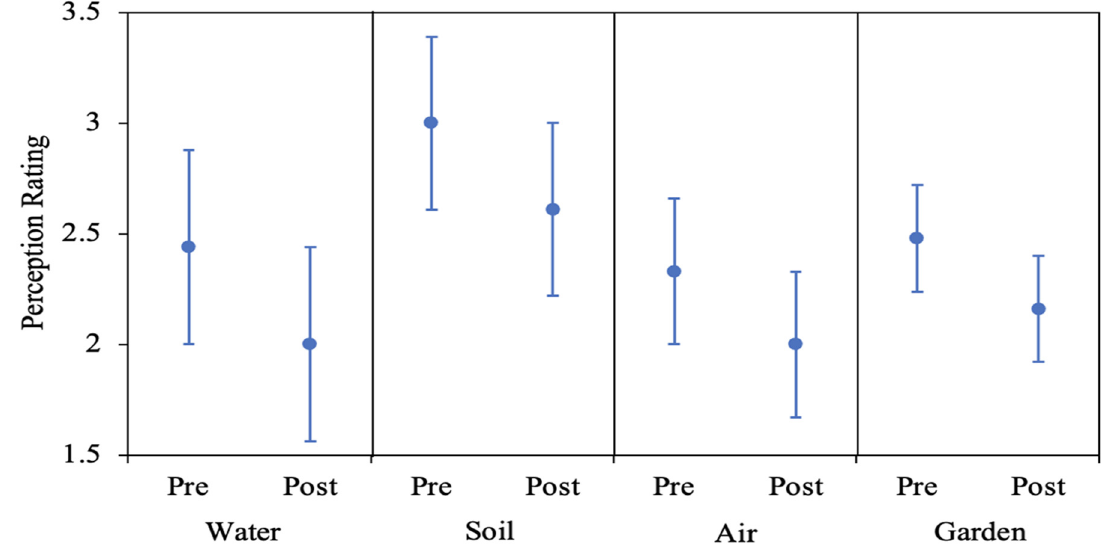
Figure 6. Interval plots comparing mean and 95% confidence intervals perception ratings before and after intervention for the three-exposure media (water, air, soil, plus garden). Y-axis title ‘perception rating’ refers to participants perception response on a 6-point Likert-type Scale: 1: Very Good; 2: Good; 3: Somewhat Good; 4: Somewhat Bad; 5: Bad; 6: Very Bad.